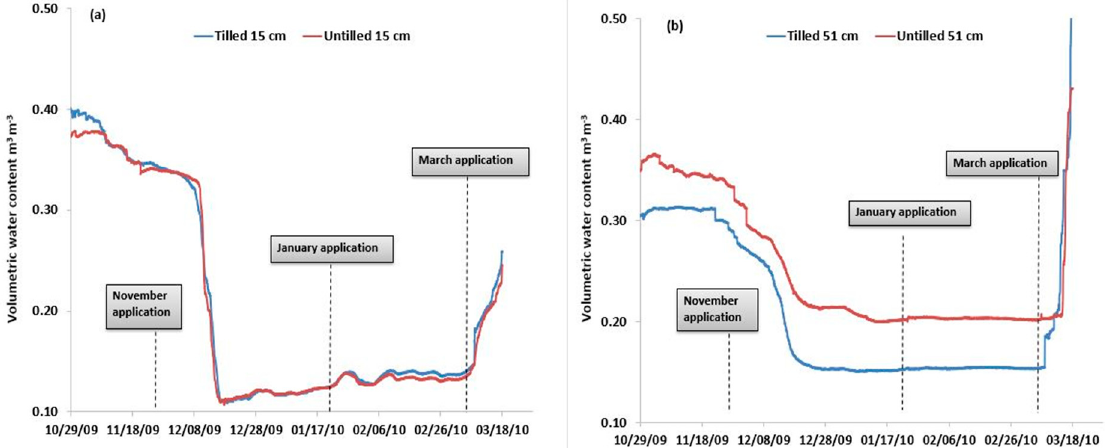
Figure 5. Soil volumetric water content (VWC) at ( a ) 15 cm, and ( b ) 51 cm soil depth for untilled and fall-tilled treatments (mean overall manure treatments); Brookings, SD.